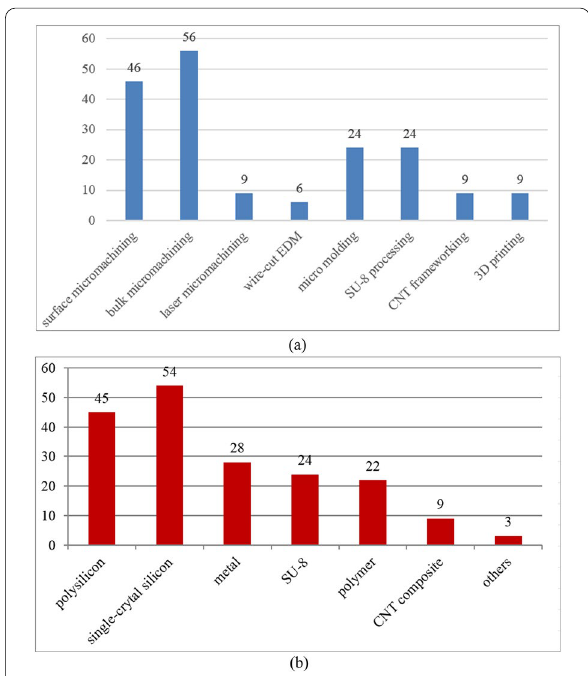
Figure 1 The statistical results for CMM in the literature ( a ) with respect to manufacturing processes and ( b ) with respect to the constituent material (The number at the top of each column represents the number of papers found for each manufacturing process or constituent material,